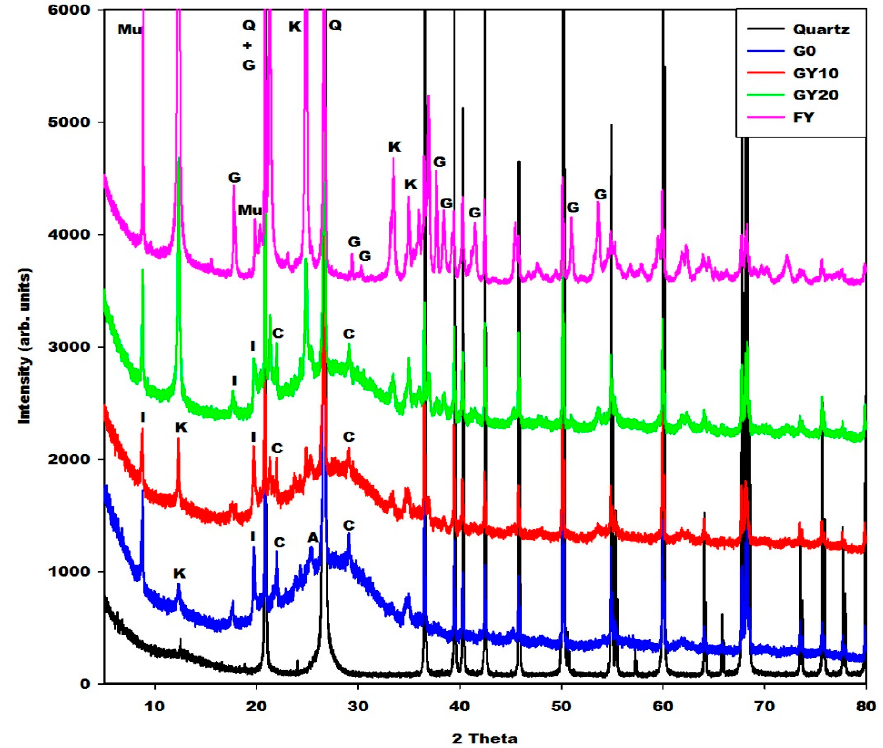
Figure 7. X-ray patterns of geopolymer materials (G0, GY10, GY20, quartz and FY). Q, I, K, A and C denotes the peaks of quartz, illite, kaolinite, anatase and cristobalite,